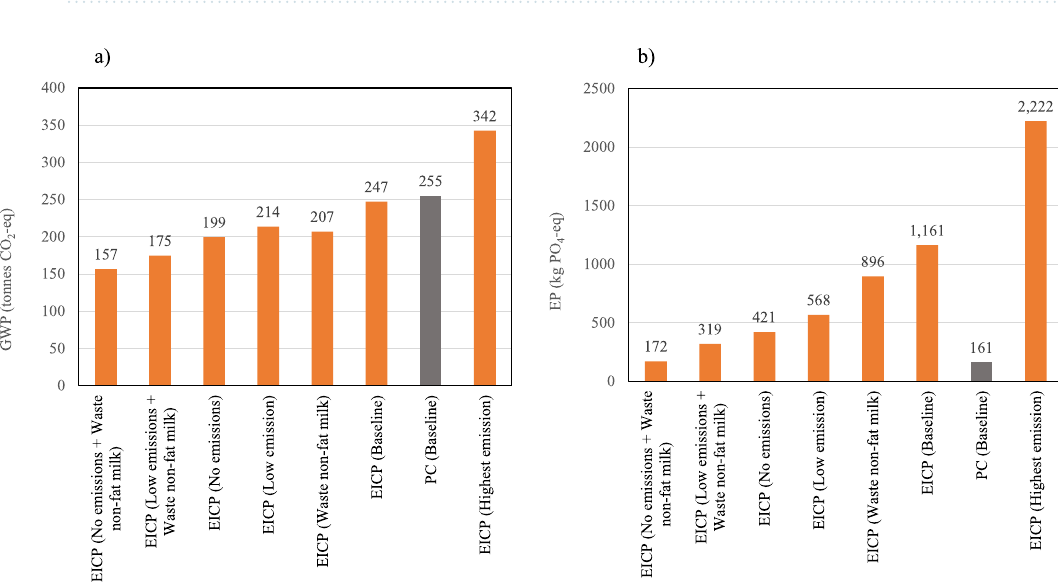
Figure 7. Sensitivity analysis scenarios of EICP compared to the PC baseline scenario for: ( a ) global warming potential, and ( b ) eutrophication